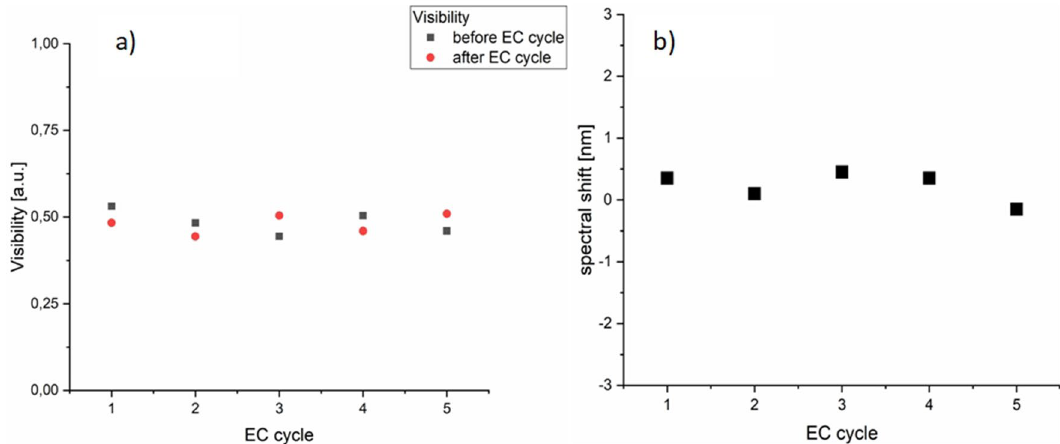
Figure 3. The analysis of the optical spectra of Fig. 2 recorded before and after each electrochemical cycle. ( a ) Fringe visibility values cluster around ~ 0.5 value due to the presence of the liquid inside the Fabry–Perot cavity. ( b ) Spectral shift between spectra recorded before and after each EC cycle. Minor changes in ( a ) and ( b ) are due to instability of the light source over time.